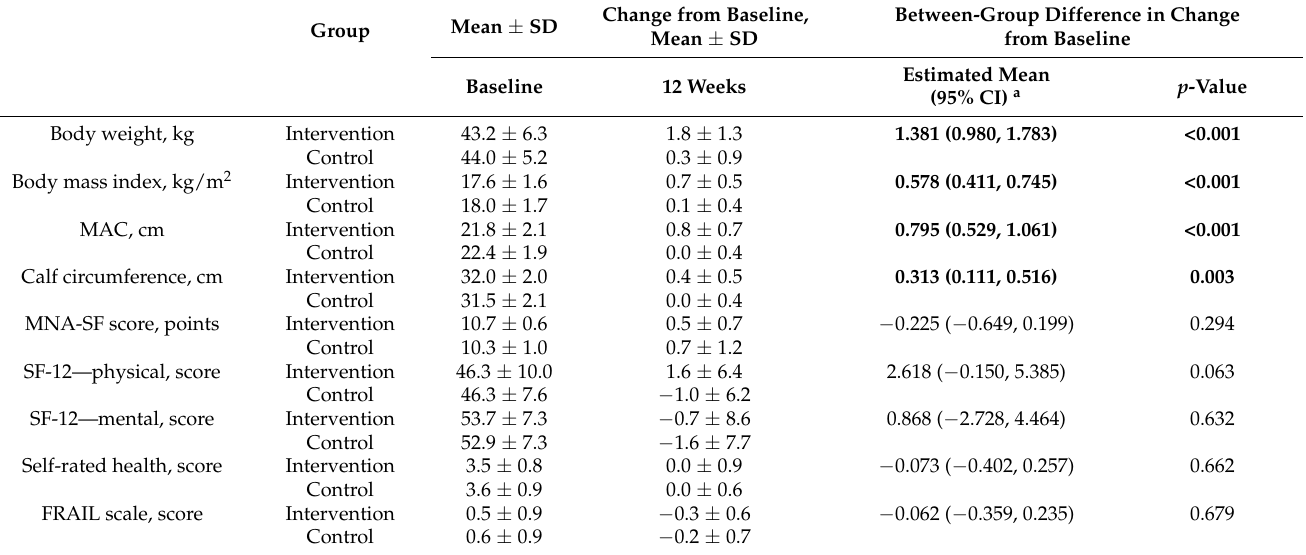
CI, confidence interval; MAC, mid-arm circumference; MNA-SF, Mini Nutritional Assessment-Short Form; SF-12, 12-item Short Form Health Survey. Data are presented as mean ± SD. Bold values represented p < 0.05. a Represents group difference (intervention group minus control group) in 12-week change estimate (12-week minus baseline). Estimated mean (95% CI) was derived from linear mixed model for body weight and body mass index and from independent-sample t -test for the other outcomes. Table 3. Energy and selected nutrient intakes at baseline, changes from baseline, and the estimated mean group differences in changes from baseline between the intervention group ( n = 42) and the control group ( n = 40). Change from Baseline, Between Group Difference in Change Mean ± SD Mean ± SD from Baseline Estimated Mean p -Value Baseline 12 weeks (95% CI) a